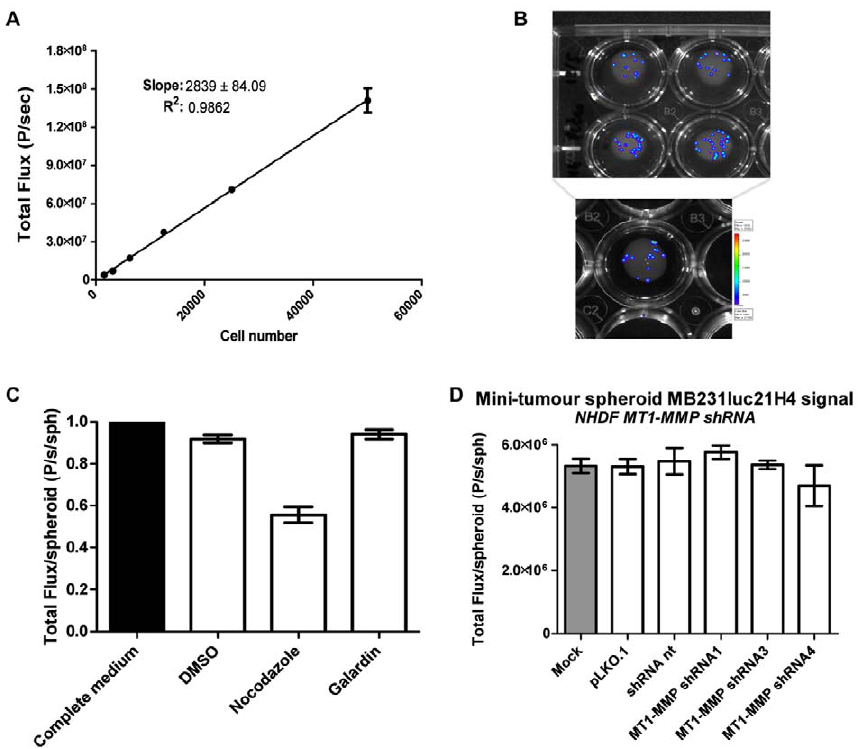
Figure 7. Bioluminescence imaging of Minitumour spheroids reveals no difference in cancer cell proliferation with MMP inhibition. A – Quantification of bioluminescence levels from MB231luc21H4 cell dilutions showing a linear relation between cell number and luciferase signal. B – Representative images showing the bioluminescence signals from sequential concentration dilutions of MB231luc21H4 cells. C – Quantification of total luminescence signal of Minitumour spheroids including MDA-MB-231-luc2 after 40 h incubation in collagen-I with galardin, a vector control and Nocodazole as a positive control for proliferation inhibition (p-value , 0.05). D – Quantification of bioluminescence signal from Minitumour spheroids made with MB231luc21H4 and fibroblasts expressing lentiviral derived shRNAs for MT1-MMP and non-targeting controls.